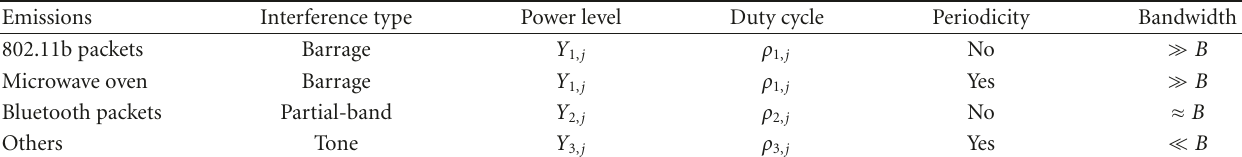
Table 1: 2.4GHz ISM band interference characteristics based on